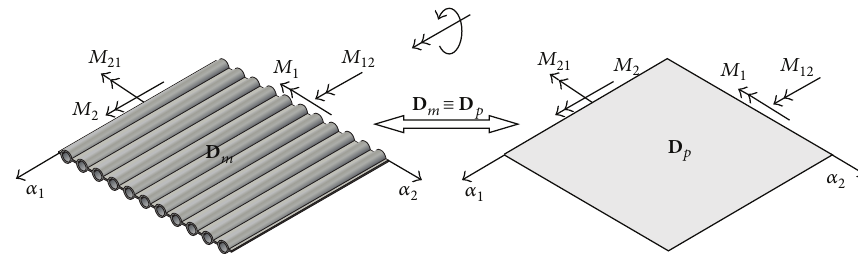
Figure 2: Section moments in the membrane wall, that is, the equivalent orthotropic plate, with the bending stiffness of membrane wall D 𝑚 equivalent to the bending stiffness of orthotropic plate D 𝑝